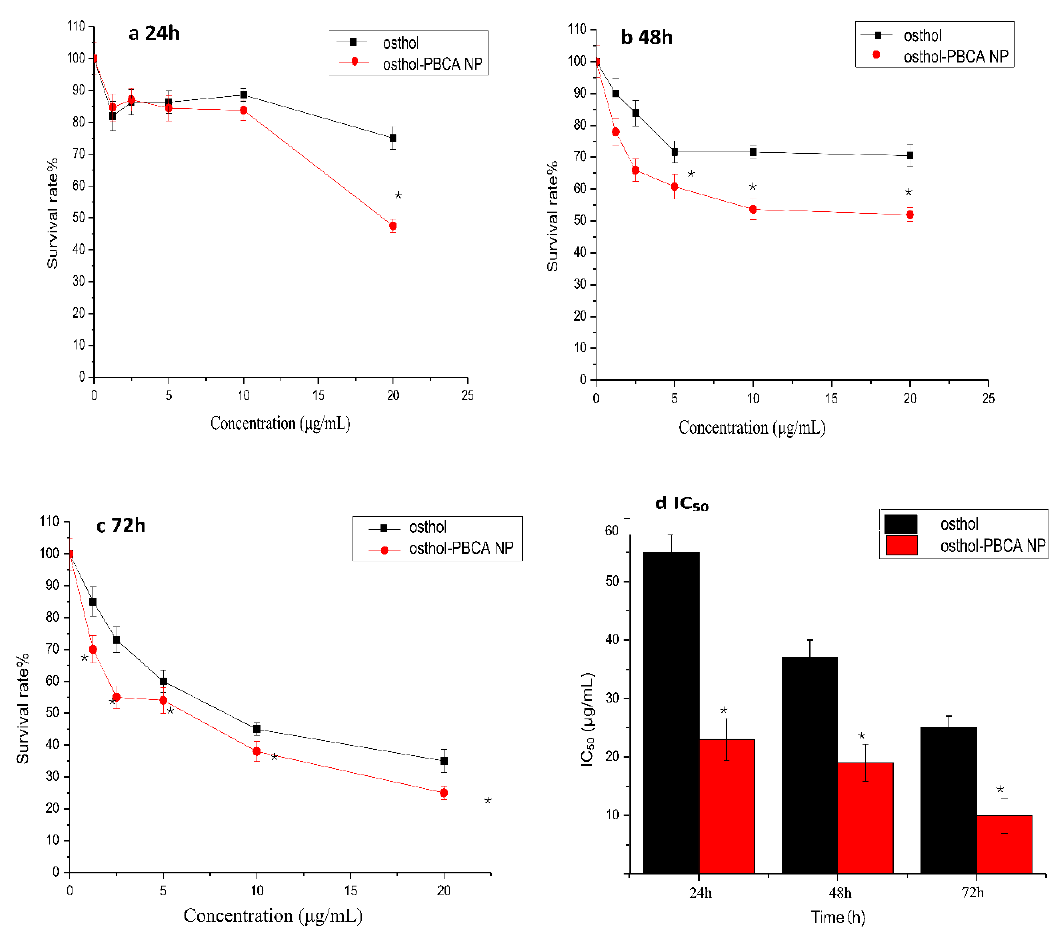
Figure 8. The survival rate and IC 50 of SH-SY5Y cells incubated with osthol and osthol-PBCA NPs for 24, 48, and 72 h ( 𝛸 ± S, n = 4, * p < 0.05 vs.